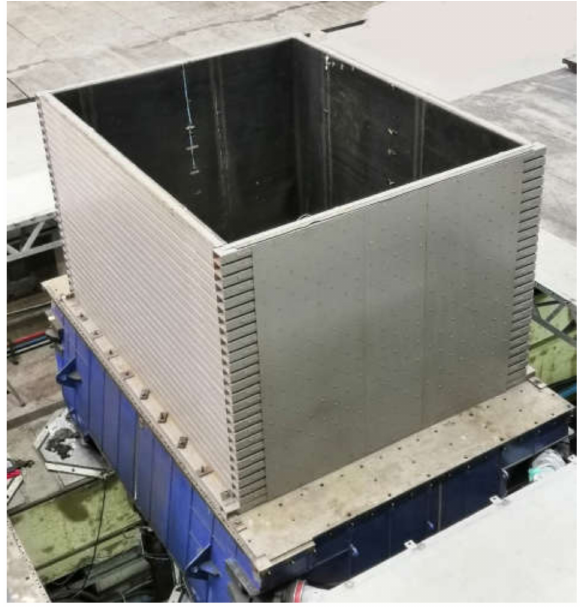
Figure 3. Installed laminar